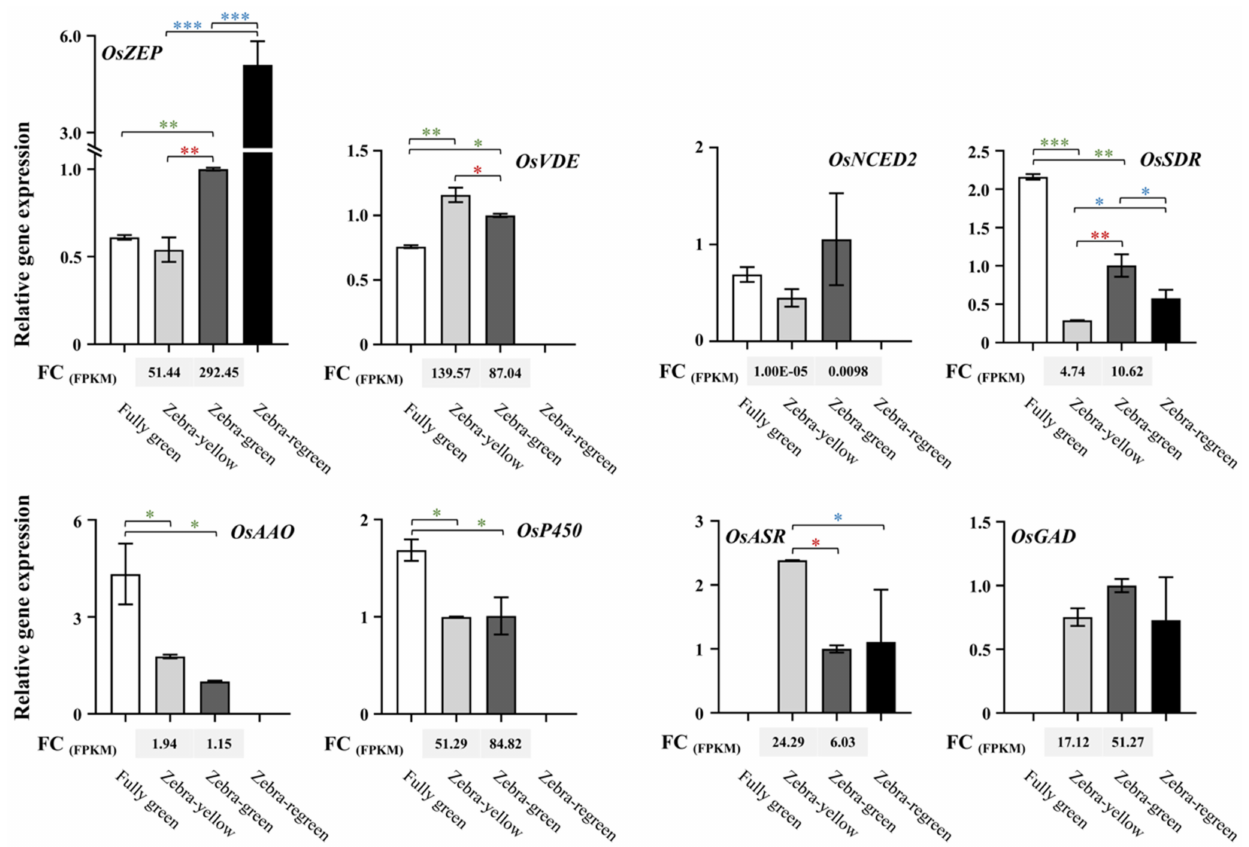
Figure 5. qPCR-based verification analysis of the expression of genes in the striped leaves of B03S. The internal reference gene is OsActin . Data are shown as mean ± standard deviation ( n = 3). Asterisks indicate significant differences revealed by Student’s t -test (*, p < 0.05; **, p < 0.01; ***, p < 0.001). Green or blue asterisks indicate the gene expressions of the striped leaves compared to those of full green leaves (CK) or regreen leaves, respectively; Red ones indicate the gene expressions between zebra-green striped and zebra-yellow striped in the striped leaves. FC, fold change; FPKM, fragments per kilobase per million calculated based on transcriptome